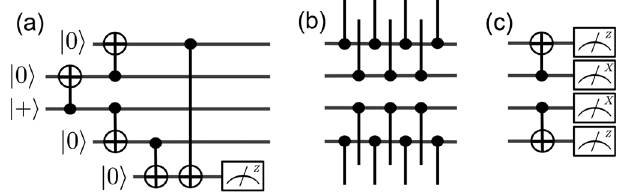
FIG. 9. (a) Preparing and verifying 4 CAT ¼ ðj 0000 i þ ffiffiffi p 2 (the measurement is postselected on finding j 0 i ). j 1111 iÞ = The circuit volume is 26, and we must wait for the postselection to succeed before proceeding. (b) The circuit coupling the 4CAT to the j CCZ i blocks in Fig. 11. All outgoing lines are to unique qubits, so this takes 4 time steps for a total circuit volume of 16. (c) The CAT decoding [49] and measurement step. Successful postselection occurs upon seeing j 0 i from both Z -basis mea- surements. The sum modulo two of the X -basis measurements gives the eigenvalue of the measured operator. The volume of this step is 8. Total volume of (a) – (c) is 50.